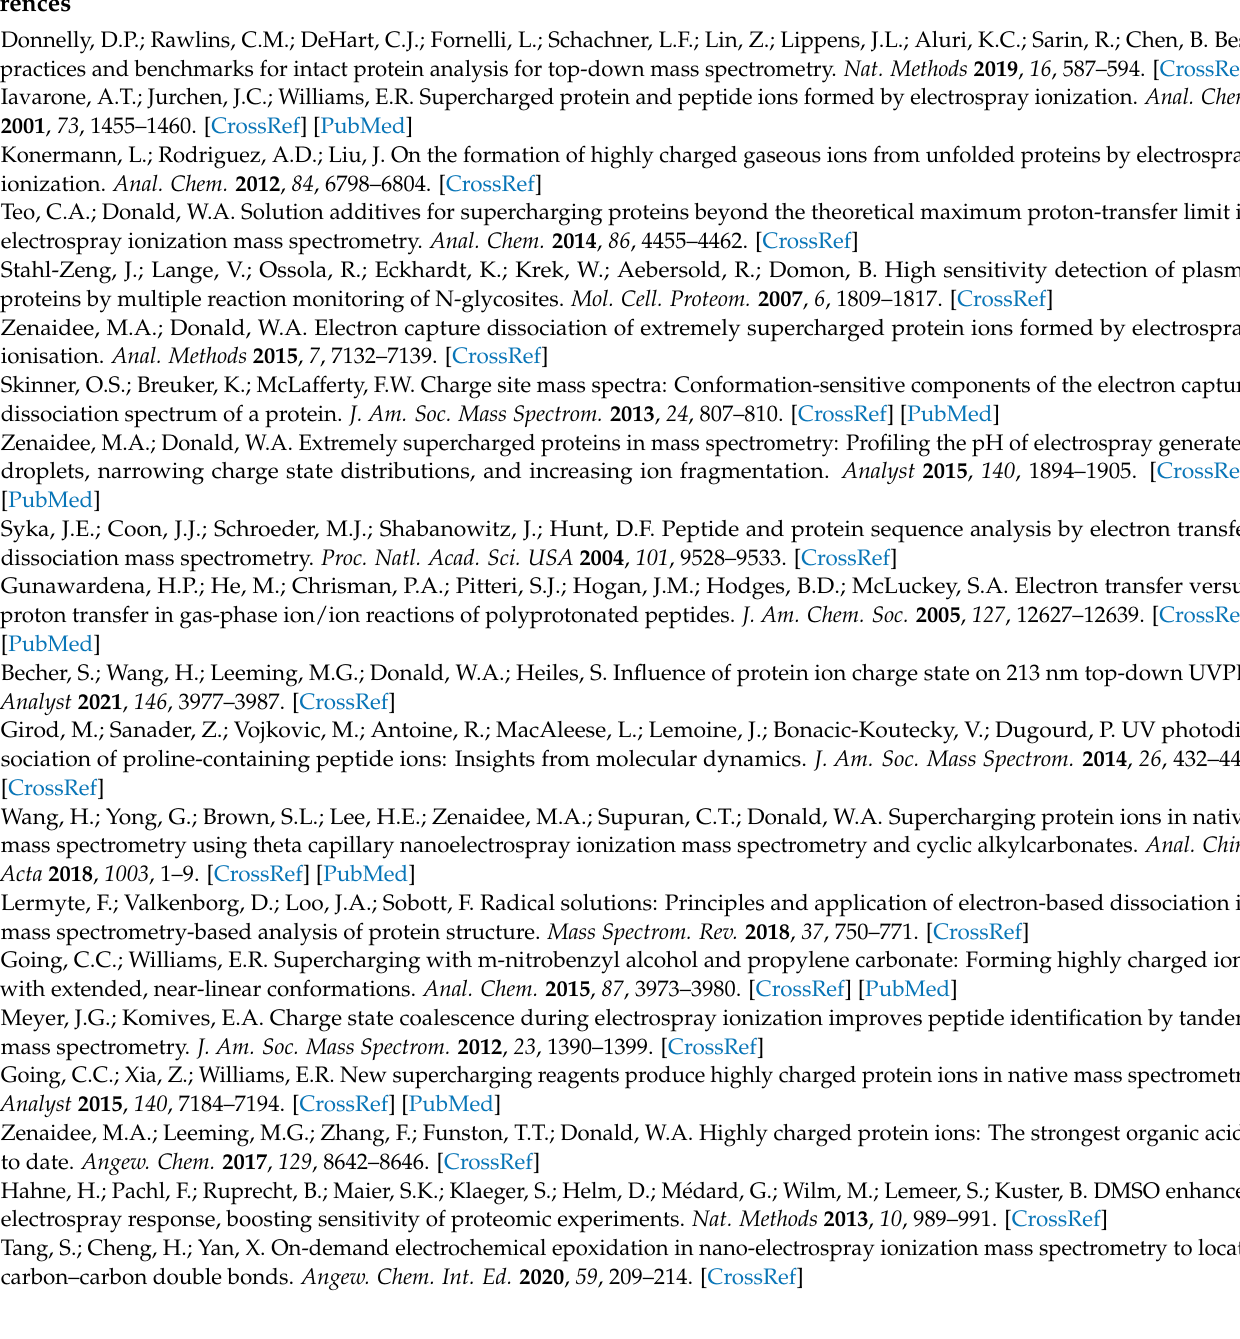
ratios, Figure S3: Effects of frequency and duty cycle on average charge states and signal-to-noise ratios, Figure S4: Mass spectra for